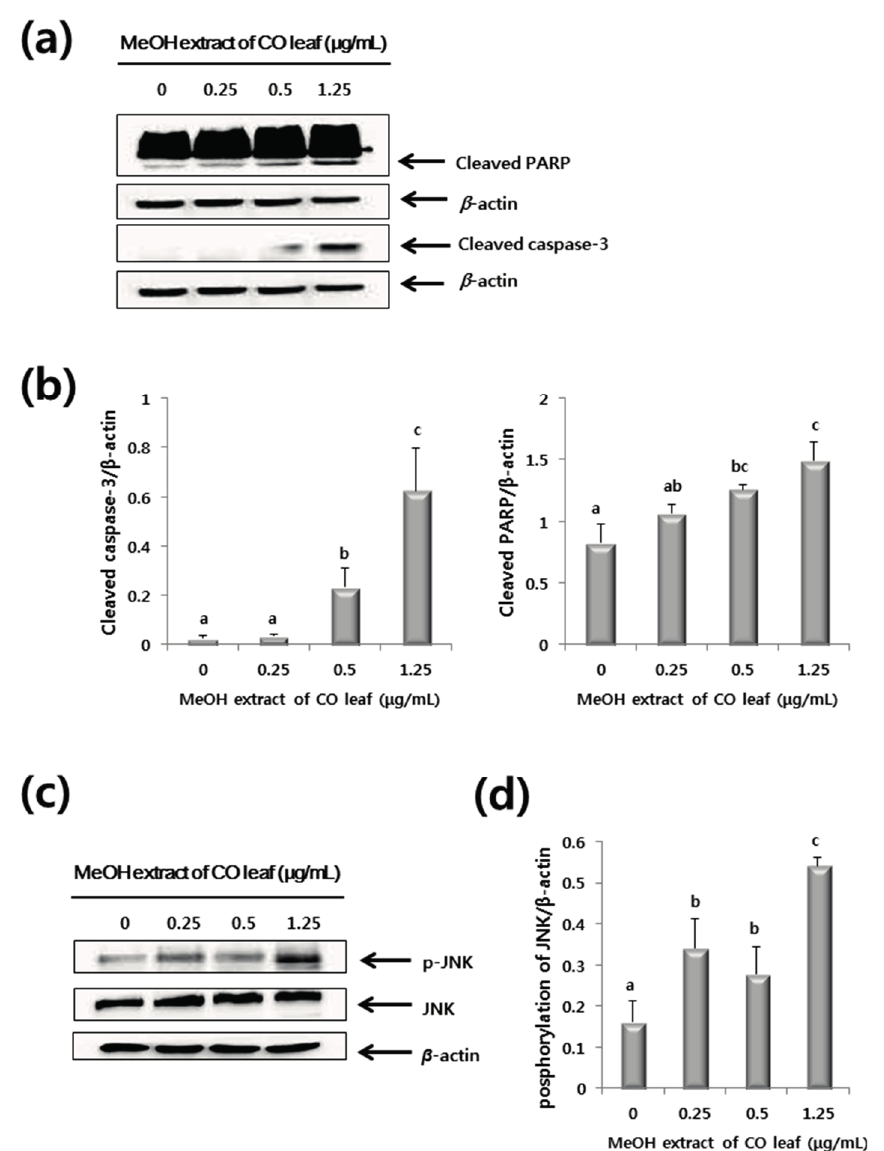
Figure 6. Western blot of HCT116 cells treated with methanol extracts of Chamaecyparis obtusa leaves. ( a ) Representative western blot of caspase-3 and poly ADP ribose polymerase (PARP) protein expression; ( b ) Expression levels of caspase-3 and PARP protein. The level of each protein was normalized to beta-actin protein levels; ( c ) A representative western blot of phosphorylated-c-Jun N -terminal kinases (p-JNK) protein expression; ( d ) Expression levels of p-JNK protein. The results are from three independent experiments and presented as mean ± standard deviation. The letter labels on the graph indicate statistically significant differences between samples ( p < 0.05) based on one-way ANOVA with Tukey’s post hoc